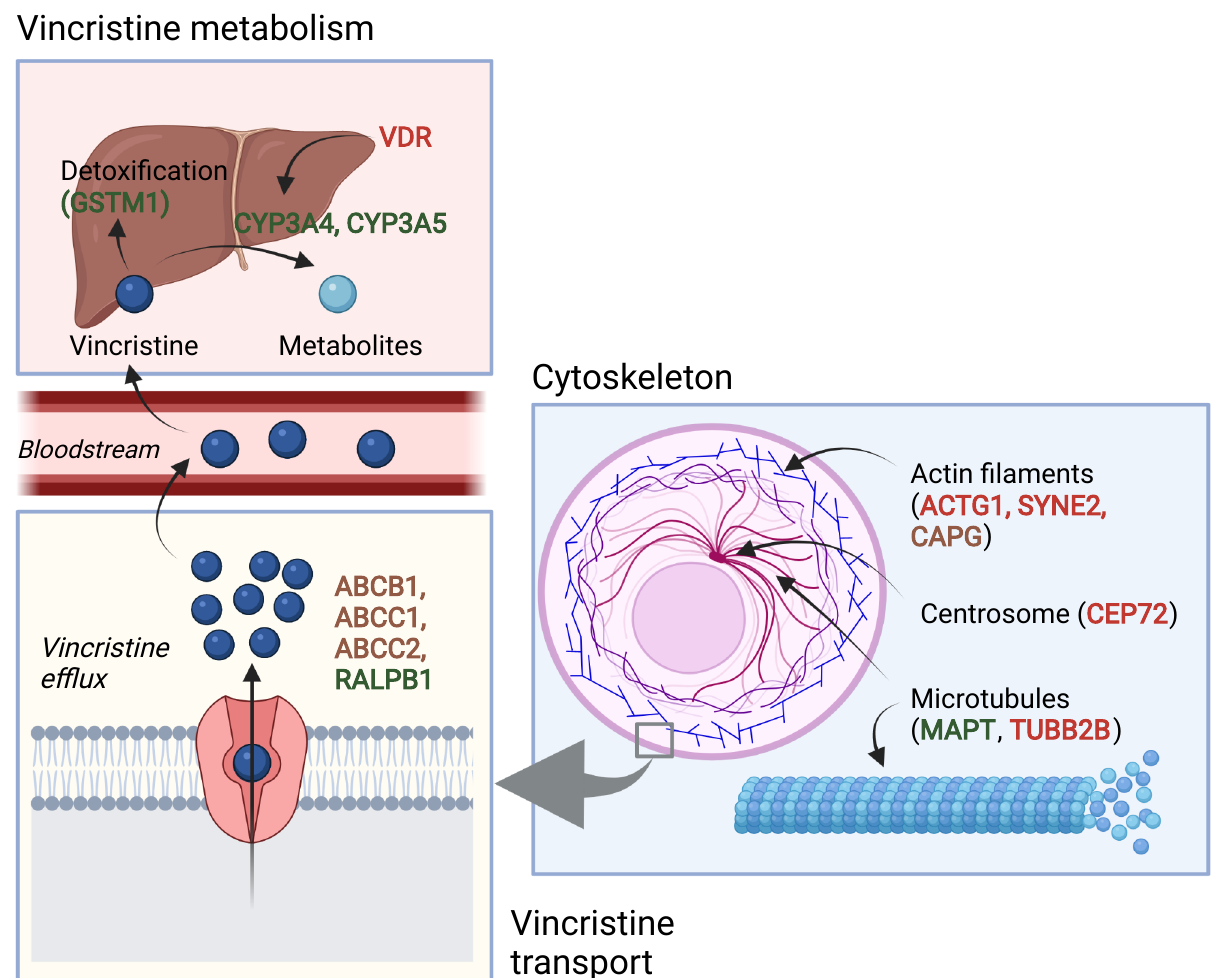
Figure 2. Schematic overview of the function of genes associated with VIPN. Red: described SNPs in this gene are associated with a higher risk of VIPN; green: described SNPs in this gene are associated with a lower risk of VIPN, brown: described SNPs in this gene are associated with both a higher and lower risk of VIPN (different per SNP). Created with